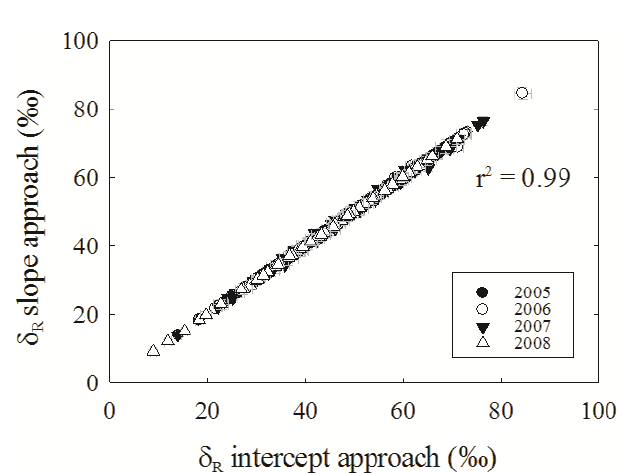
Fig. A4. The relationships between modeled δ R and observed δ R . Dark and open circles represent model output after and before the one-way flux model (Cernusak et al., 2004) was incorporated, re- spectively. Data are included from DOY 100 to 273.